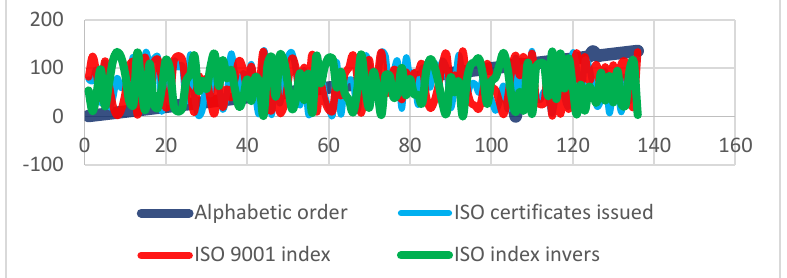
Figure 1. The rank of countries as per the alphabetic order (dark blue), number of ISO 9001 certificates (light blue), ISO 9001 index (red), and ISO 9001 inversed index (green), (136 countries